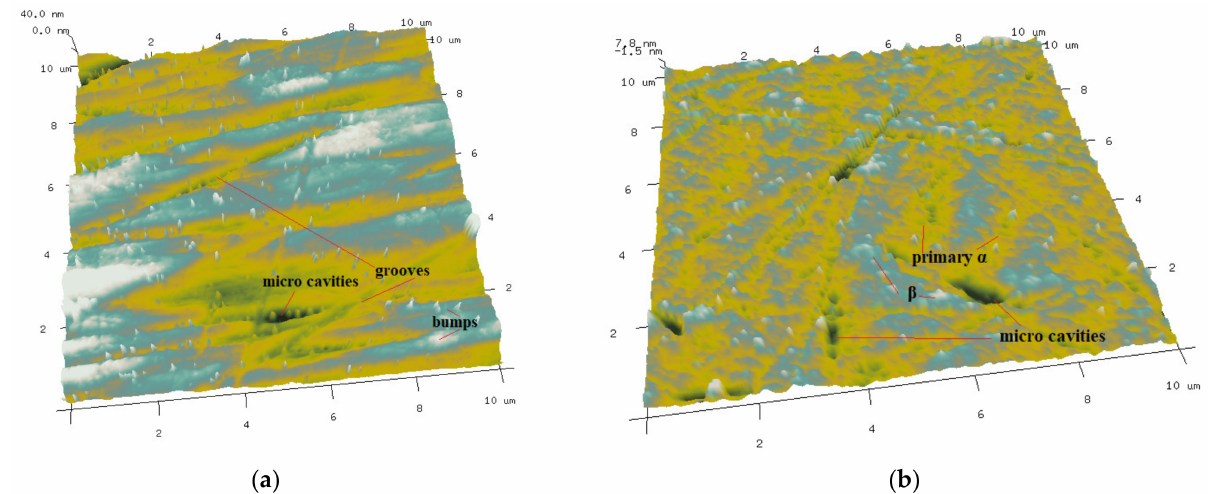
Figure 10. AFM surface micro morphology of Ti-6Al-4V before and after polishing. ( a ) Before polishing. ( b ) After polishing.